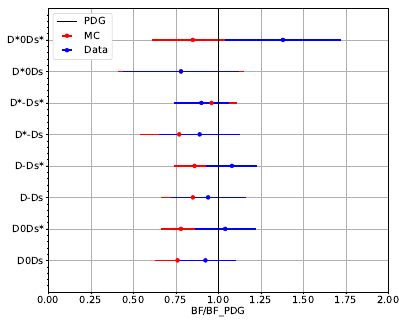
Figure 3. Branching ratios for reference channels for GMC (red) and data (blue) relatively to PDG values